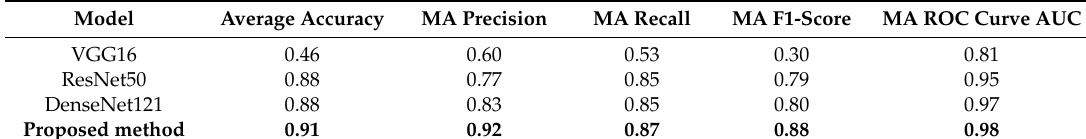
Table 6. Macro-average measures for all CNN models.